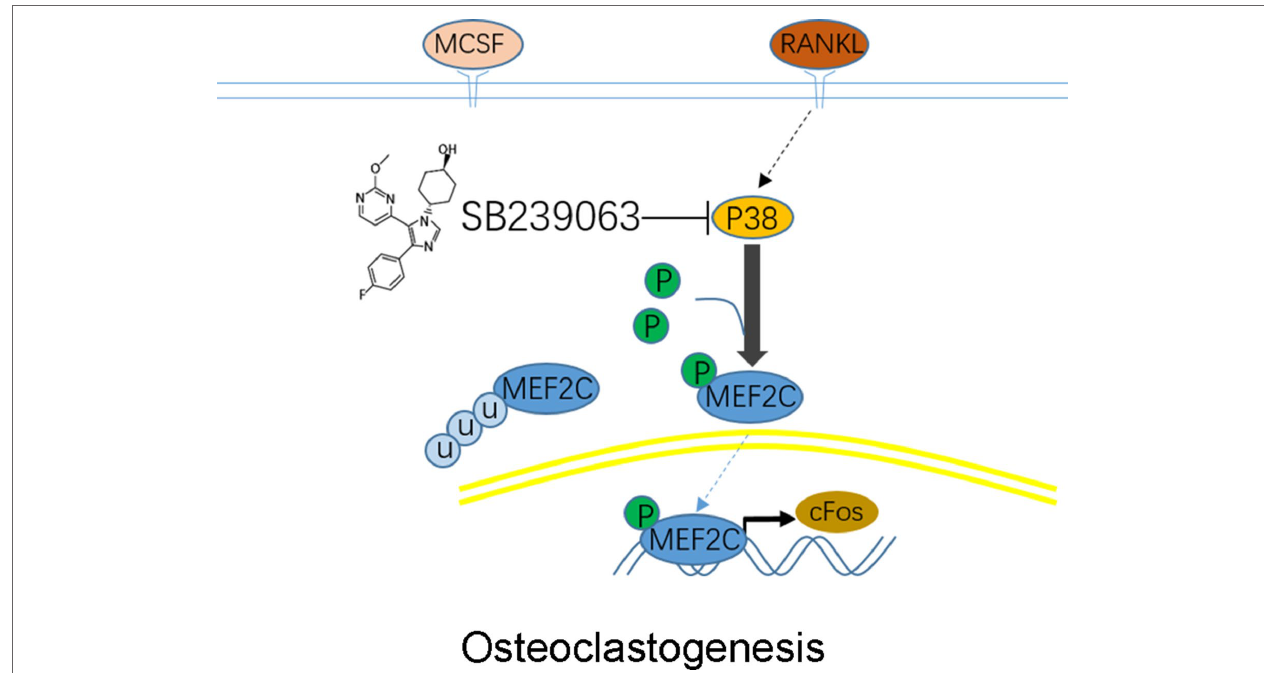
FIGURE 6 | Schematic representation of experiments. Osteoclastogenic signaling cascade controlled by SB239063, inhibitors of p38 mitogen-activated protein kinases (MAPK). Arrows indicate activation of the signaling pathways, while T bars indicate inhibition of the signaling